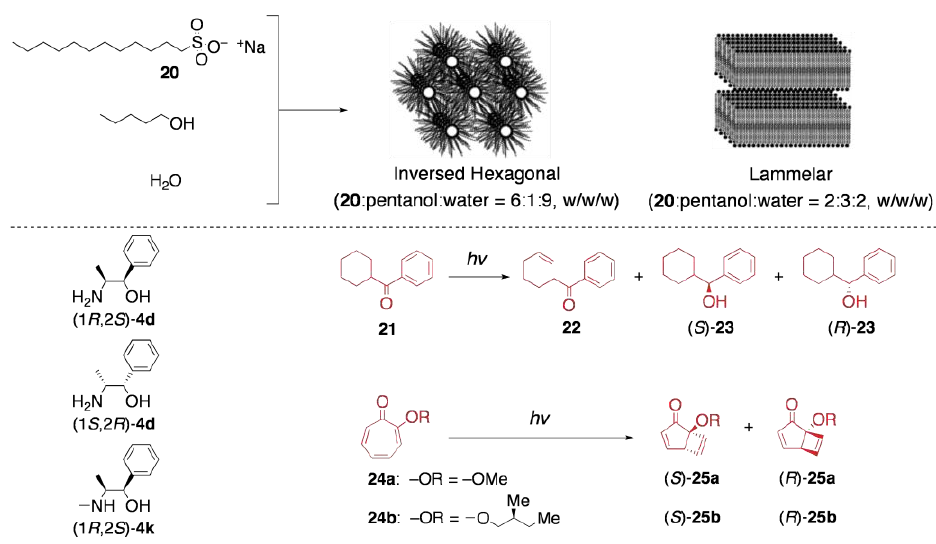
Figure 10. Asymmetric synthesis in lyotropic